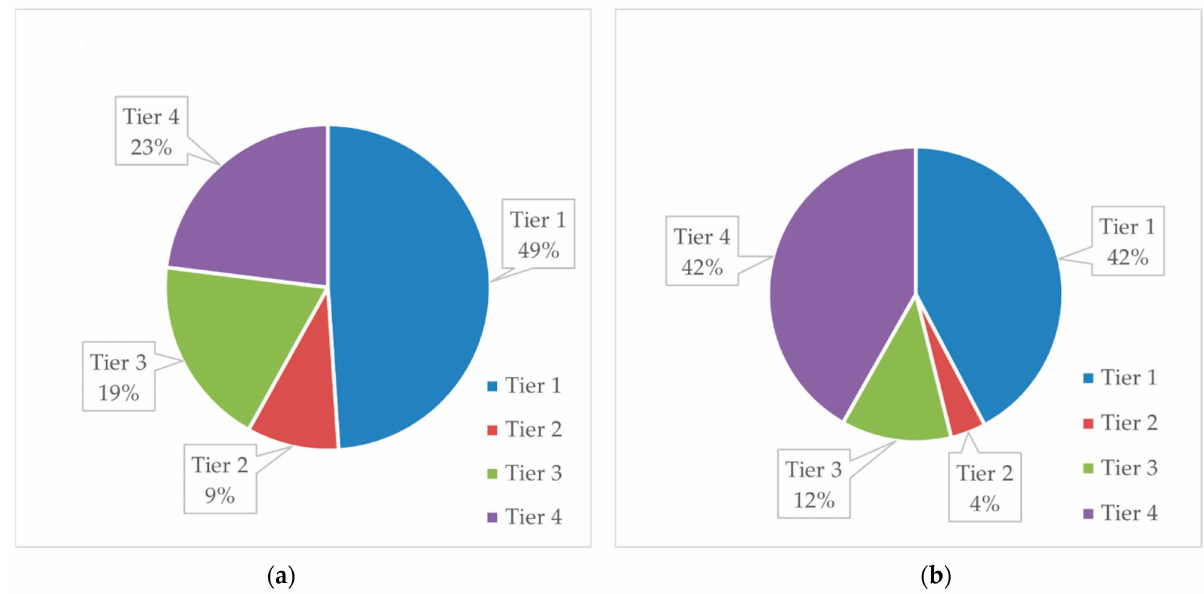
Figure 9. ( a ) Percentage of time spent in each cloud cover band for a year; ( b ) percentage of time spent in each cloud cover band for December 2019 and January 2020.